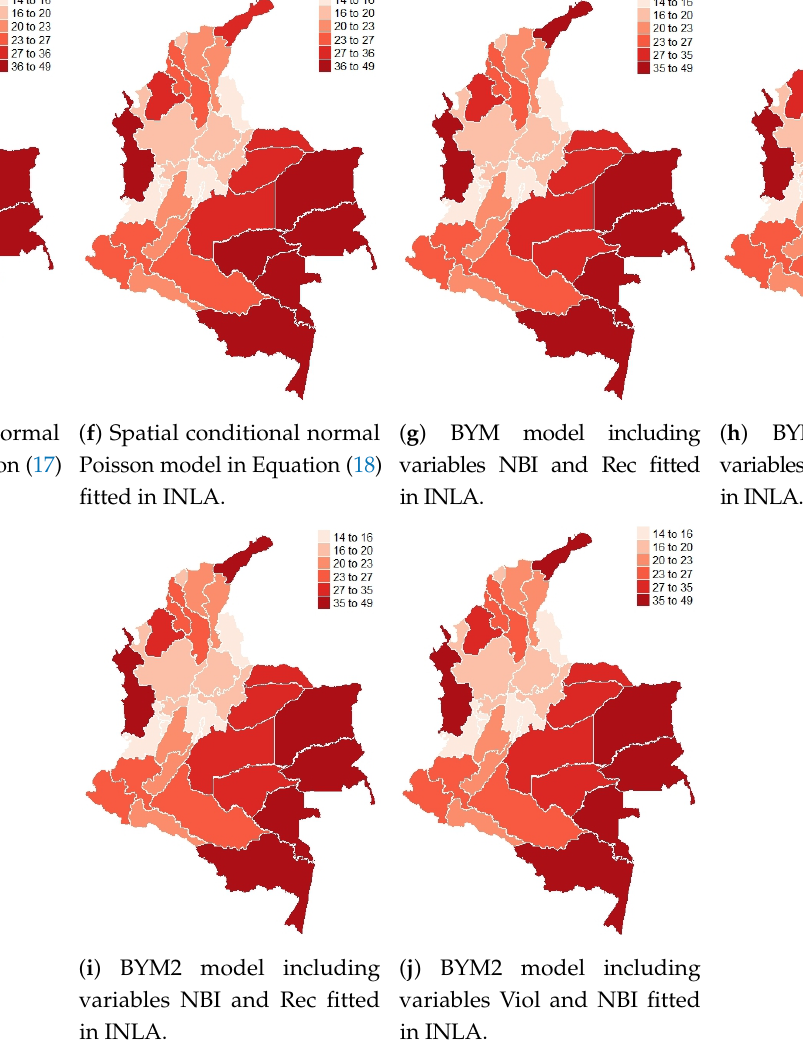
Figure 9. Maps of the observed and estimated mortality rates obtained from some of the fitted models to the Colombian infant mortality rates data